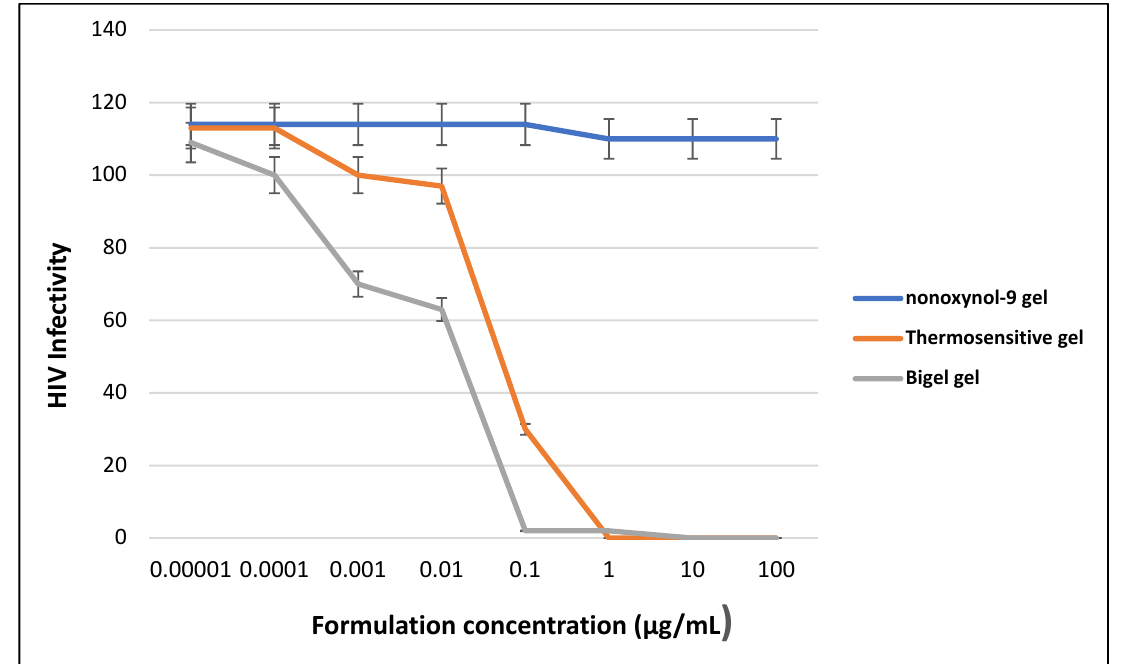
Figure 6. HIV infectivity dose-response curve for the optimal thermosensitive and bigel, containing maraviroc and tenofovir microspheres and nonoxynol-9 gel, incubated with HIV-1 indicator TZM-bl cells at different concentrations ( n = 5 ± SD). No significant difference between the mean HIV infectivity values of the thermosensitive and bigel ( p > 0.05).